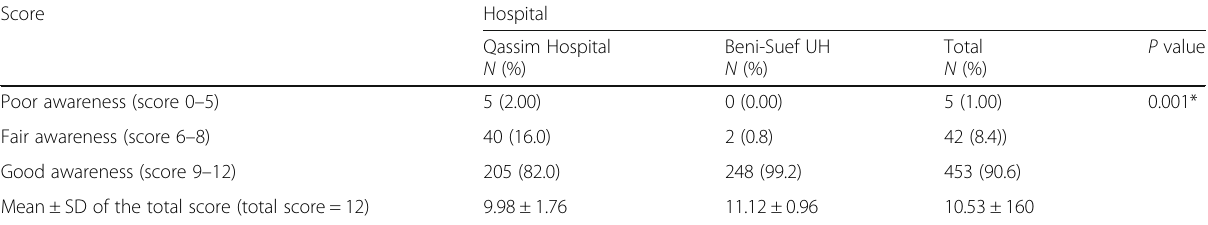
Table 3 Comparison of safe injection awareness score among the nurses in Beni-Suef, Egypt, and Qassim, KSA, 2017